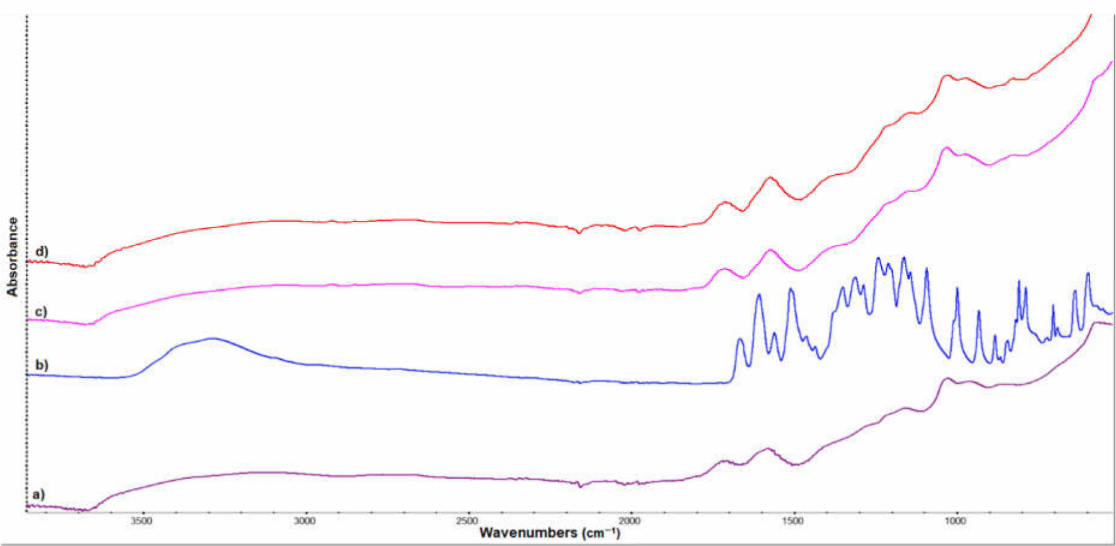
Figure 2. FTIR spectra for ( a ) GO, ( b ) Qu, ( c ) GOQu 2.5% ( w / v ) (quercetin loaded onto GO nanocar- rier), and ( d ) GOQu 5% ( w / v